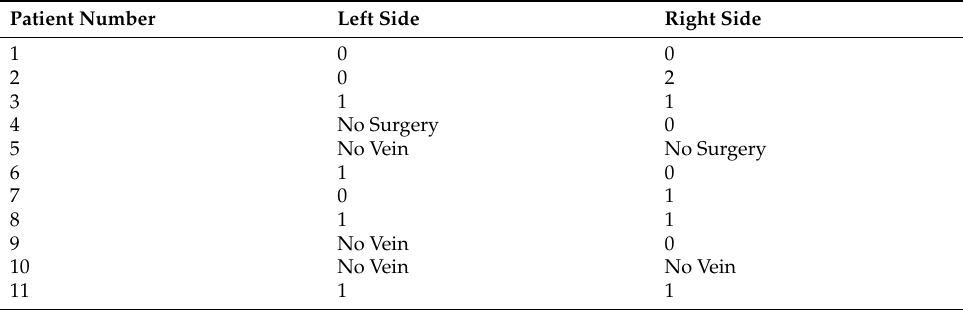
Table 3. Number of lymph nodes in each